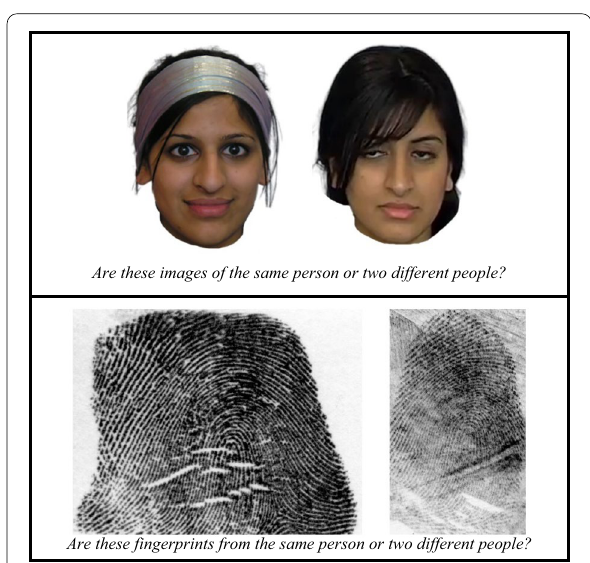
Fig. 1 Example ‘match’ trials for both matching tasks (face: upper panel; fingerprint: lower